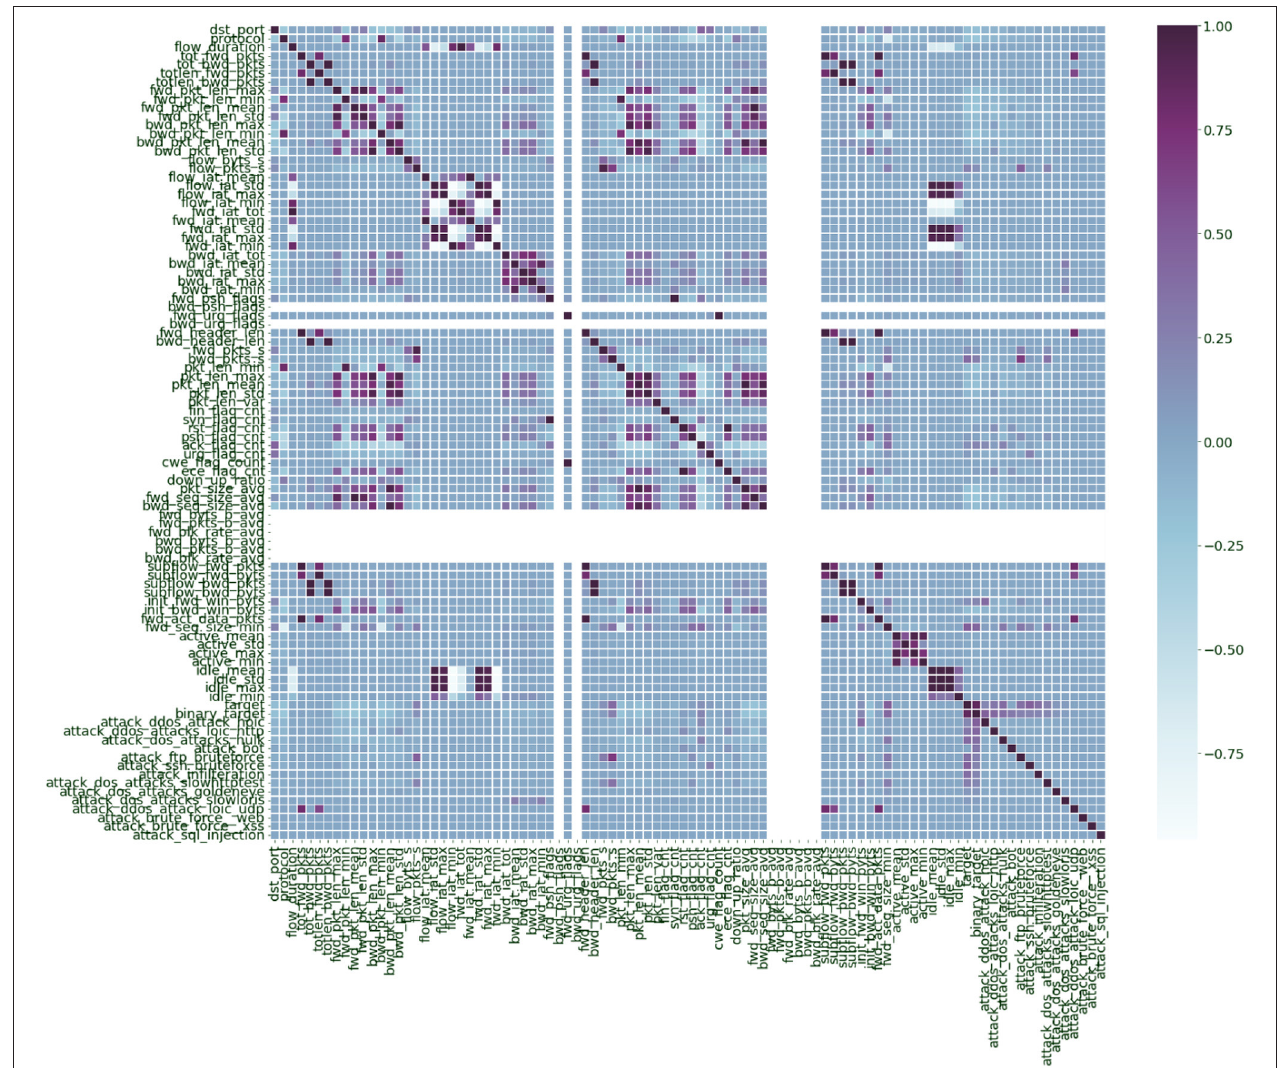
FIGURE 2 | Correlation plot of the features in the combined CIC IDS 2017 and CIC IDS 2018 dataset.